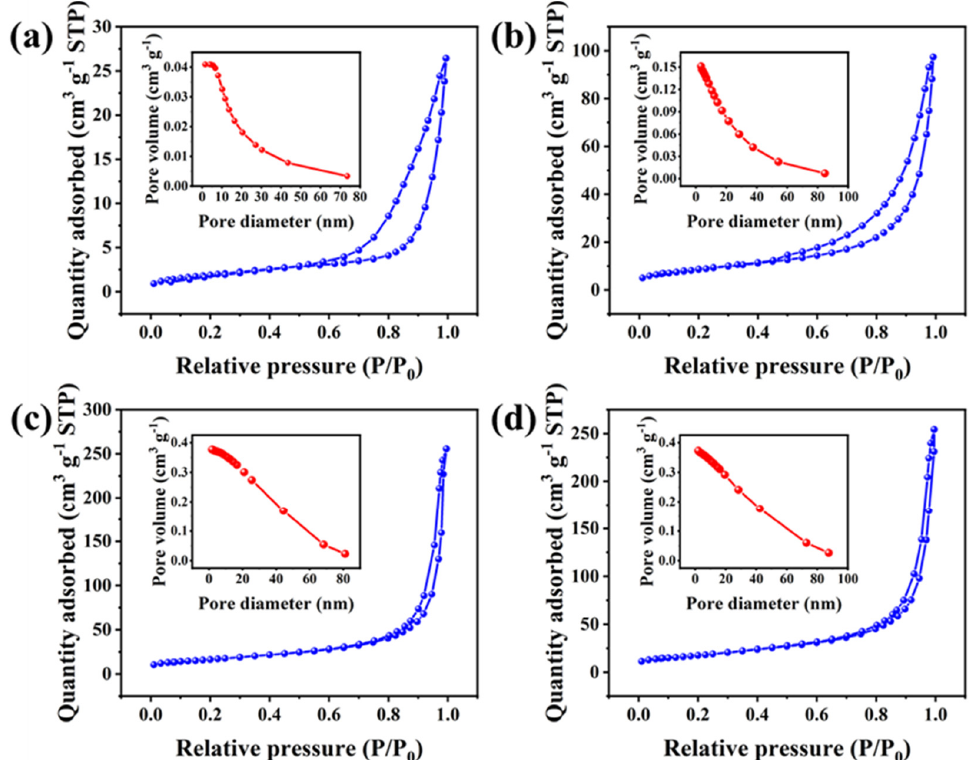
Figure 4. N 2 adsorption/desorption isotherms and pore-size distribution (inset) of ( a ) Ni 2 Co 1 S 4 , ( b ) Ni 2 Co 1 S 4 -E, ( c ) Ni 2 Co 1 Al LDH, and ( d ) Ni 2 Co 1 Al LDH-E.